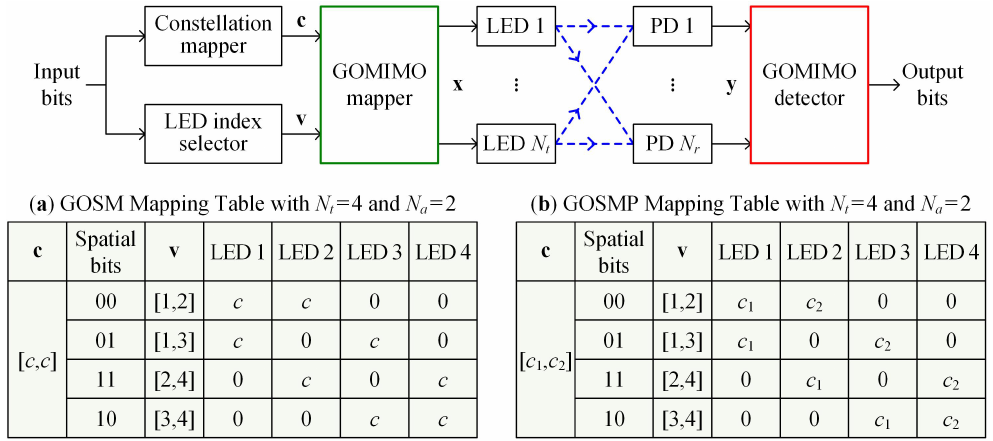
Figure 1. Block diagram of a general N r × N t GOMIMO system. Insets ( a ) and ( b ) show the mapping tables of GOSM and GOSMP,